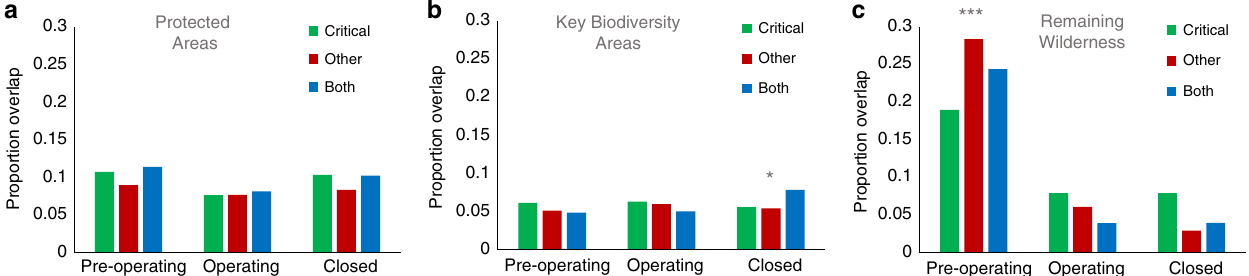
Fig. 3 Overlap betweenmining and biodiversity conservation among critical, other and both mining areas. Bars depict the areal proportion of critical, other, and both mining areas that overlap with currently Protected Areas (panel a ) and conservation priorities (Key Biodiversity Areas [panel b ] and Remaining Wilderness [panel c ]). Mining areas were mapped using a 50-cell radius around known mining properties, separated into those that are listed as being in pre-operational, operational, and closed phases. Stars denote signi fi cance differences (* p < 0.05, *** p < 0.0001) among areas targeting different commodity types (critical, other, and both) within a mining phase (pre-operational, operational, and closed). Results hold when de fi ning mining areas using a 10-cell radius around mining properties and when sampling at 300 km intervals. Note : Graphed proportions were calculated from full extent of mining and non-mining areas, whereas reported statistics were calculated using the 1 km 2 cells sampled at 100-cell overlap for areas with operational (7.5% vs. 7.1%; chi-squared = 0.03, p = 0.86) and closed mining properties (8.0% vs. 4.4%; chi-